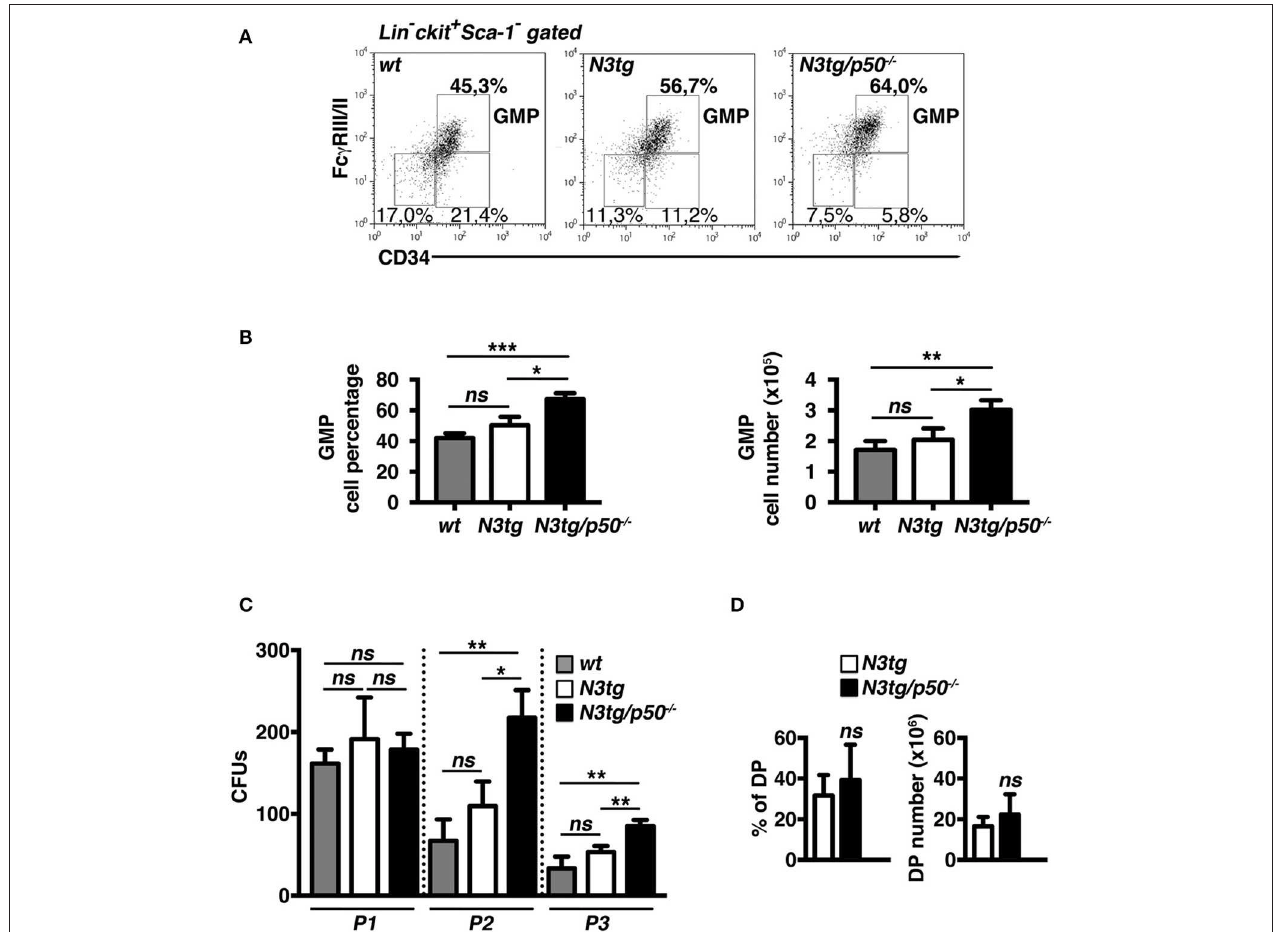
FIGURE 4 | GMP progenitors accumulate in the BM of N3tg/p50 − / − mice. (A) Representative dot plots showing CD34 vs. Fc γ RIII/II distribution inside Lin − cKit + Sca-1 − gated cells in the BM of N3tg/p50 − / − , N3tg, and wt mice at 4–5 weeks of age, as assessed by flow cytometry analysis of bone-marrow progenitor subsets (GMP, Granulocyte/Monocyte progenitors: CD34 + Fc γ RII/III + ; CMP, Common Myeloid progenitors: CD34 + Fc γ RII/III low ; MEP, Megacariocyte/Erithroid progenitors: CD34 − Fc γ RII/III low ), Numbers inside each cytogram represent the percentages of different subsets. (B) Percentages ( left panel ) and absolute numbers ( right panel ) of GMPs in the BM of N3tg/p50 − / − , N3tg and wt mice, measured as in (A) . (C) Colony forming assay of purified BM Lin − cells plated on semi-solid methylcellulose medium in the presence of factors stimulating the differentiation of progenitors toward a myeloid fate. Graph represents the mean number of colonies per plate (CFUs) obtained at any of the three re-plating points examined (P1, P2, and P3), for N3tg/p50 − / − , N3tg , or wt cells. In (B,C) data represent mean ± SD of three independent experiments ( n = 3 mice per group). ns, not significant; * P ≤ 0.05, ** P ≤ 0.01, and *** P ≤ 0.001 represent significant differences between the indicated groups. (D) Percentages ( left panel ) and absolute numbers ( right panel ) of DP T cells in the BM of N3tg/p50 − / − vs. N3tg mice at 4–5 weeks of age, as measured by flow cytometry analysis of CD4 vs. CD8 distributions. The values are presented as mean ± SD of five independent experiments ( n = 5 mice per group). ns, not significant differences between the